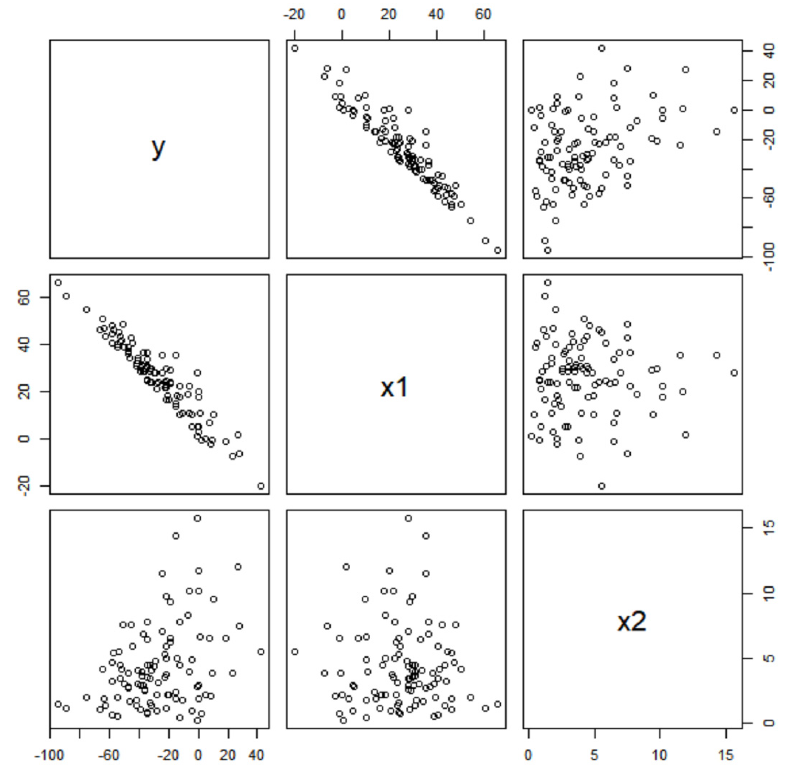
Figure 4. Plot matrix of simulation data. Table 3. Estimated parameters and intervals: simulation data.